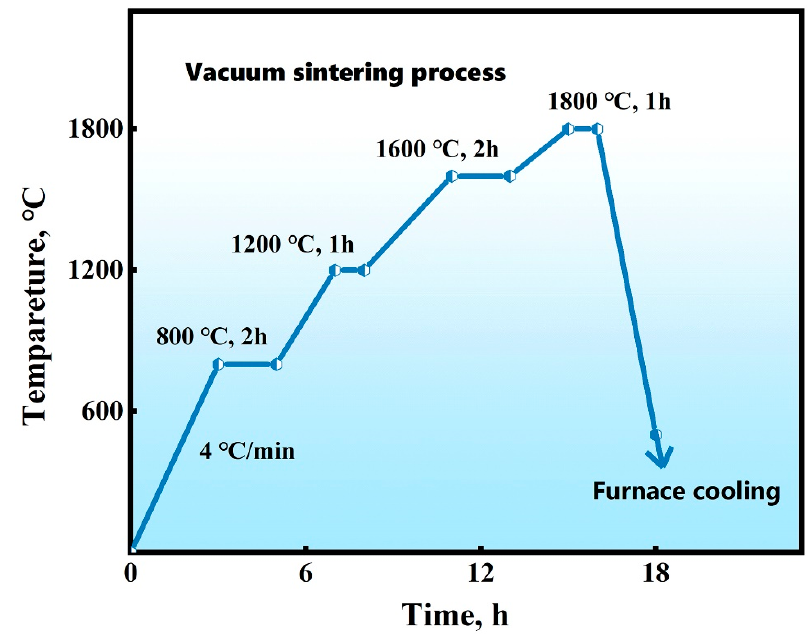
Figure 3. Vacuum sintering process.